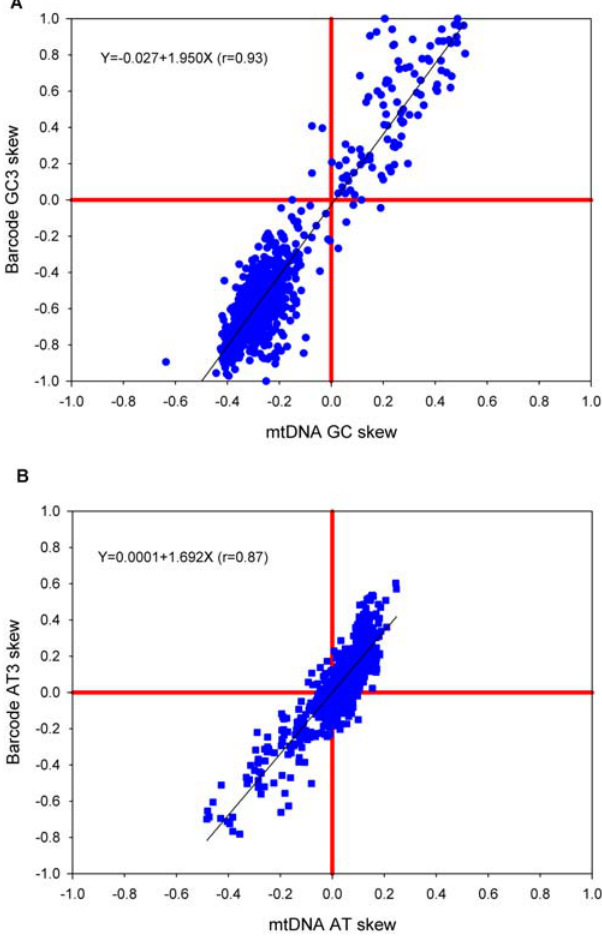
Figure 5. Correlations between nucleotide skews in the entire mitochondrial genome and in the DNA barcode sequences (third codon position only). Panel A shows the results for GC skew [(G-C)/ (G + C)]. Panel B shows the results for AT skew [(A-T)/(A +